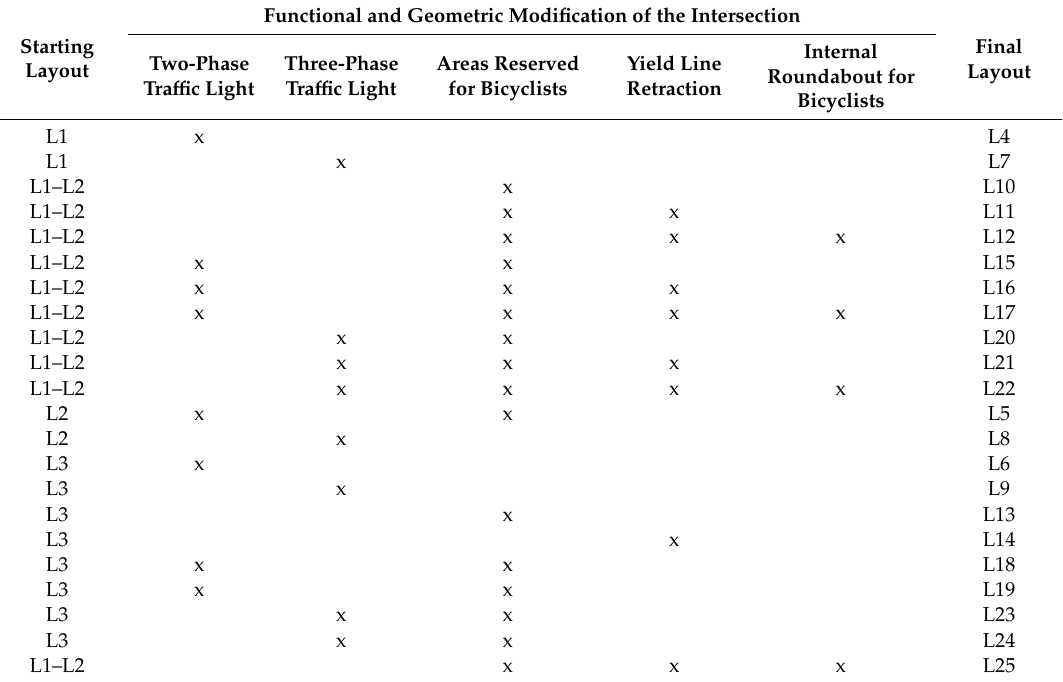
Table 2. Characteristics of the examined